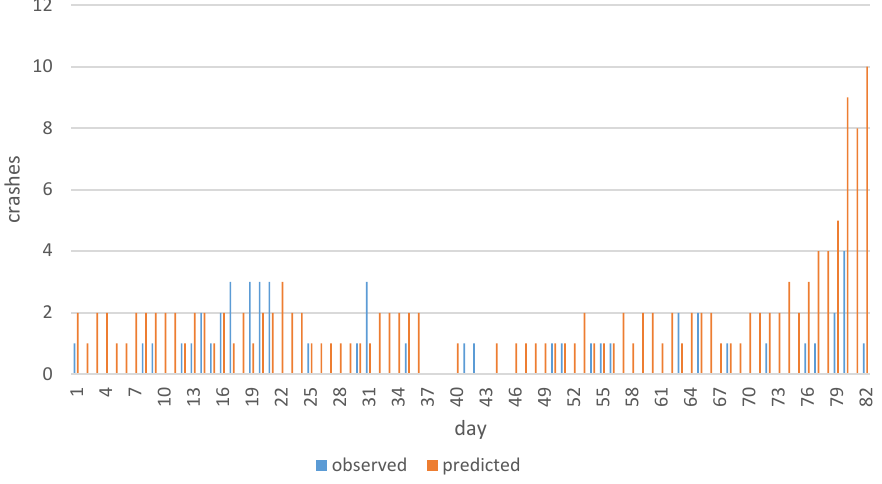
Figure 10. Prediction in Soochow direction of SVR. Figure 12. Prediction in Soochow direction of SVR.